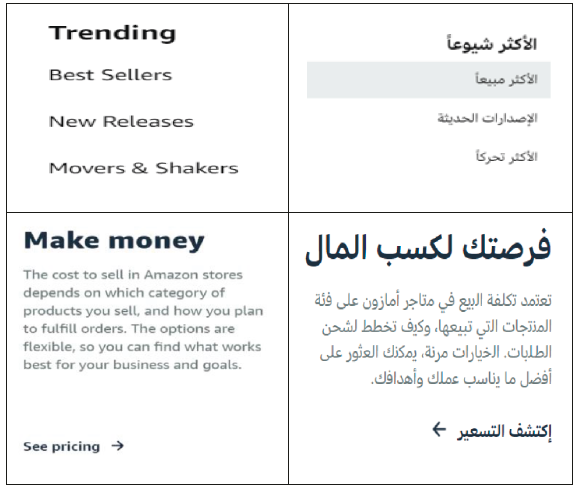
Figure 14: Examples of translated